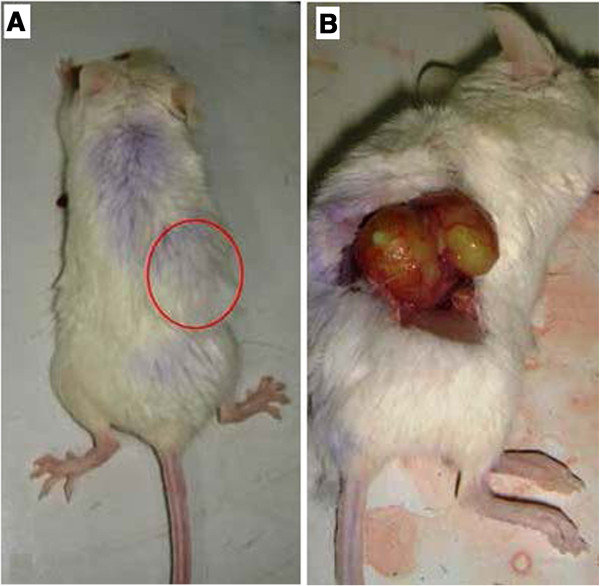
A: Before laparotomy. The injected right bottom side is higher than the surrounding skin. B: After laparotomy. Laparotomy can enable the observation of the planting of increased ovarian tumors.